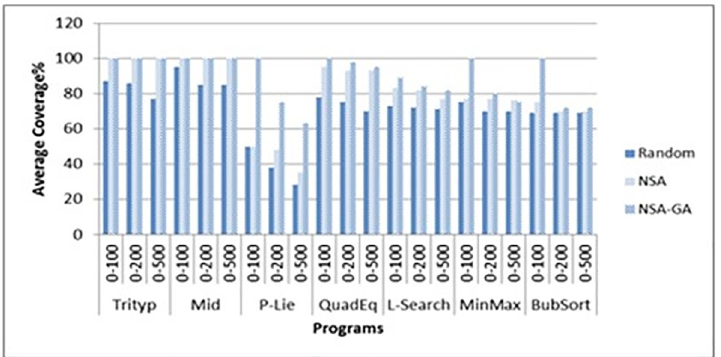
Fig 12. Comparison between AC of random testing, NSA and NSA-GA methods using different ranges for integer input data.